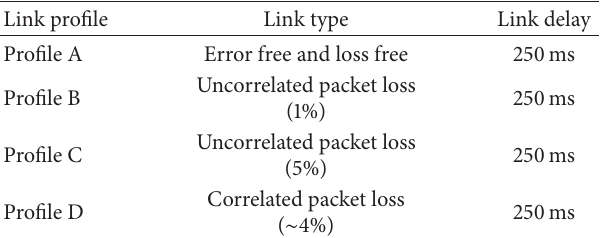
Table 6: Satellite channel